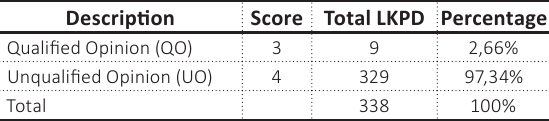
Table 4. Frequency of LKPD audit opinion